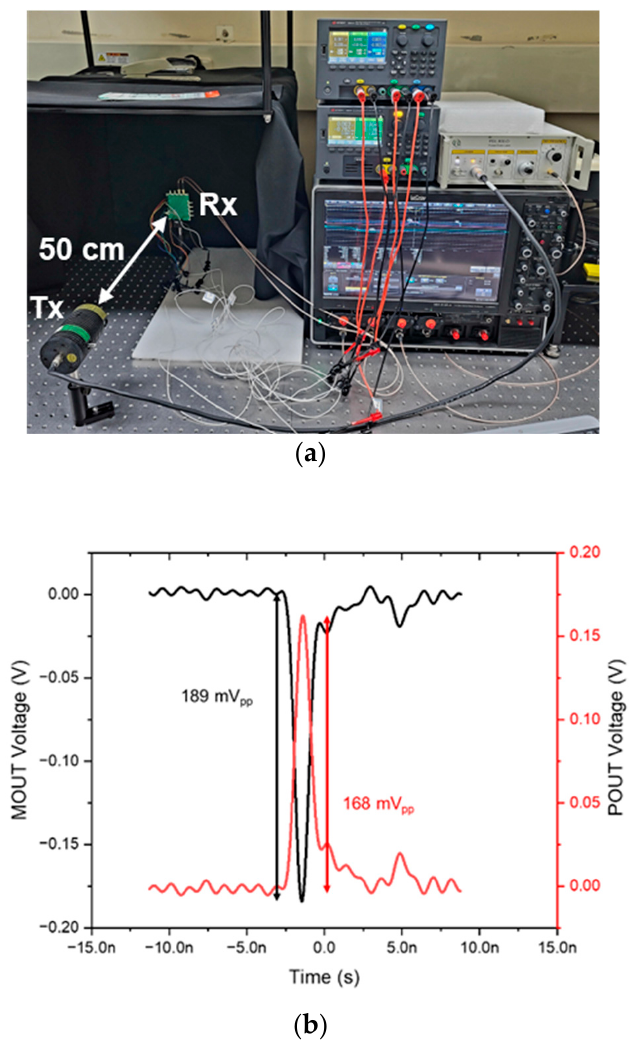
Figure 8. ( a ) Test setup for optical measurements; ( b ) optically measured pulse response.